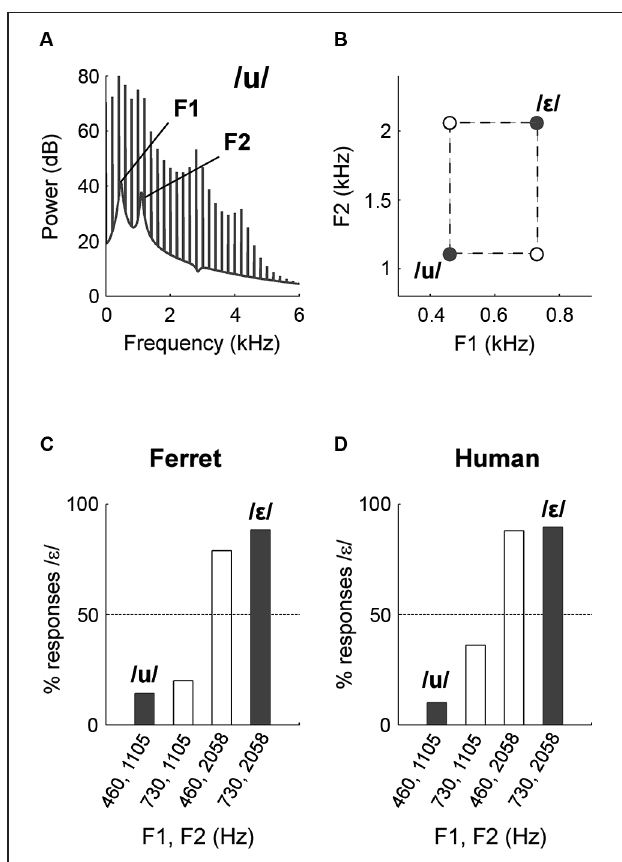
FIGURE 2 | (A) The position of the F1 and F2 peaks in the spectral envelope of a synthetic vowel /u/. (B) Formant space indicating the position of vowels used to measure the relative contributions of F1 and F2 in vowel identification. Filled circles indicate vowels with which subjects were trained in a 2AFC task. Open circles indicate mismatch vowels presented as probe trials. (C) Responses of one ferret to training (filled bars) and probe vowels (unfilled bars). (D) Responses of one human to training (filled bars) and probe vowels (unfilled